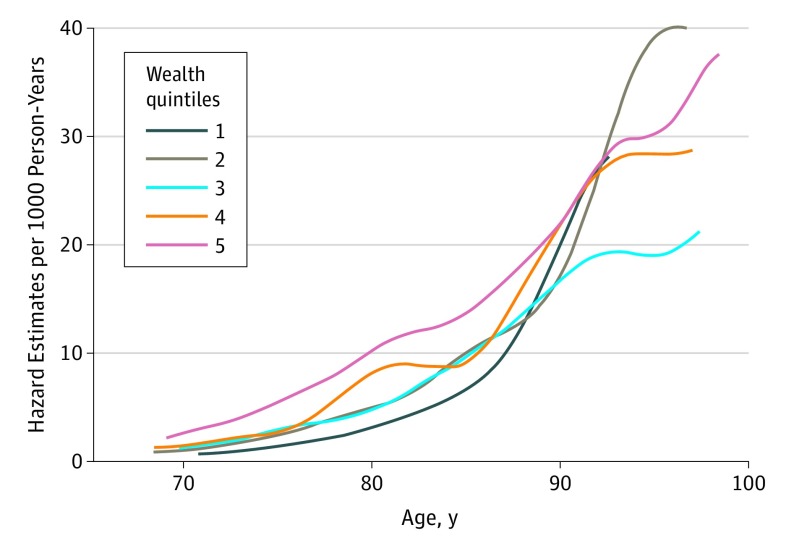
Smoothed Hazard Estimates by Age per 1000 Person-Years by Wealth Quintiles in the
English Longitudinal Study of AgeingWealth quintile 1 indicates the highest level of wealth; quintile 5, the lowest.